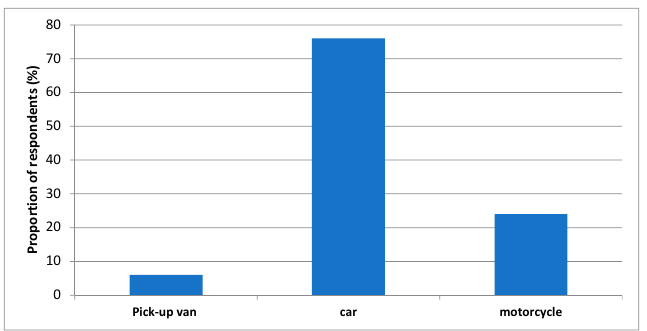
Figure 2. Distribution based on transportation system ( n = 50).